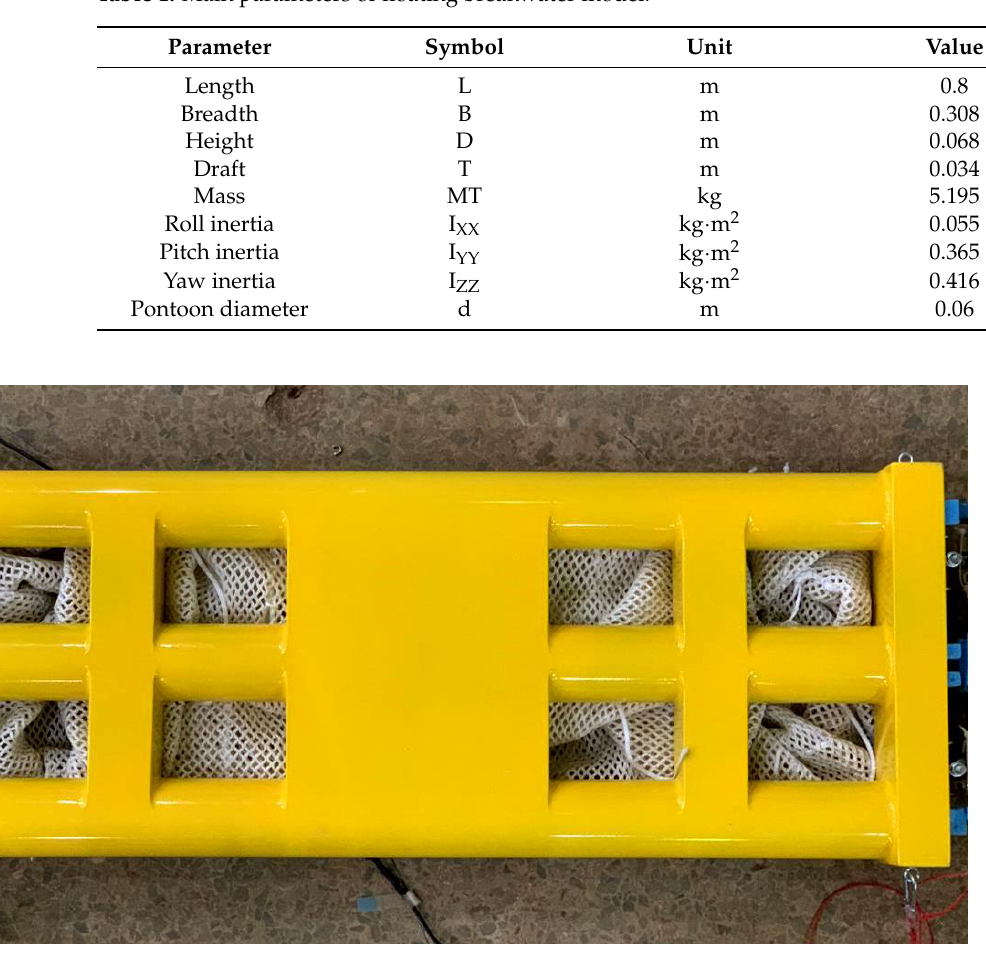
Figure 13. Top view of the floating breakwater model.